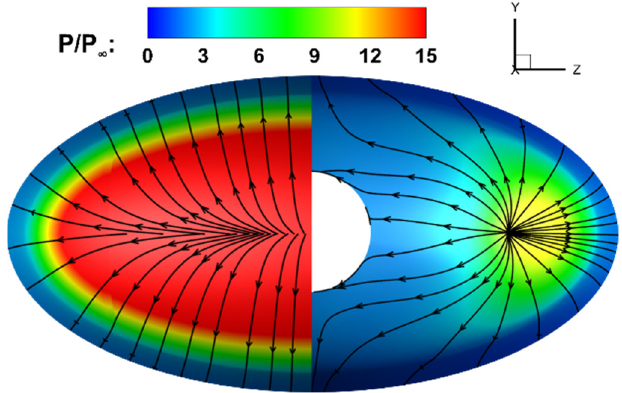
Figure 7. HIFiRE-5 streamlines near the aerodisk.